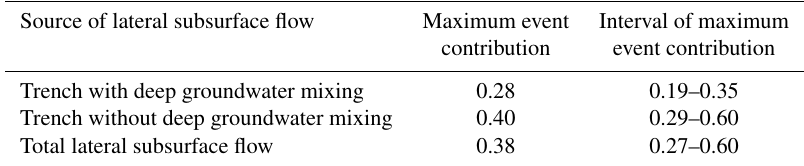
Table 4. Simulated maximum event contribution by Model 2 and the interval of maximum event contribution based on the 308 behavioral parameter sets.